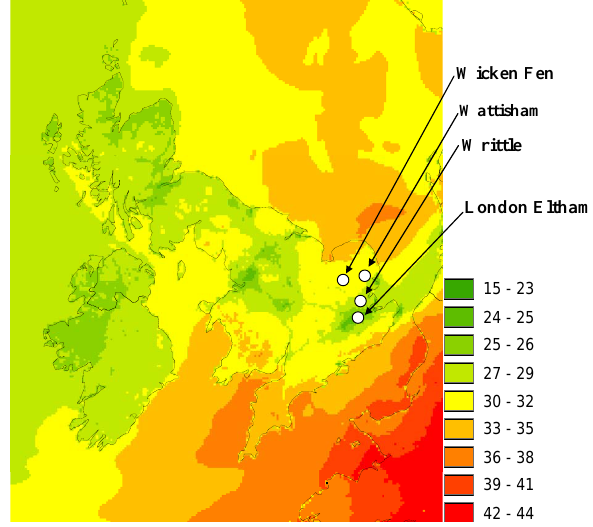
Fig. 7. Monthly mean (August 2003) surface ozone (ppb) calculated Figure 7: Monthly mean (August 2003) surface ozone (ppb) calculated by the EMEP4UK by the EMEP4UK model. The white dots indicate the sites included model. The white dots indicate the sites included in this work. in this work.